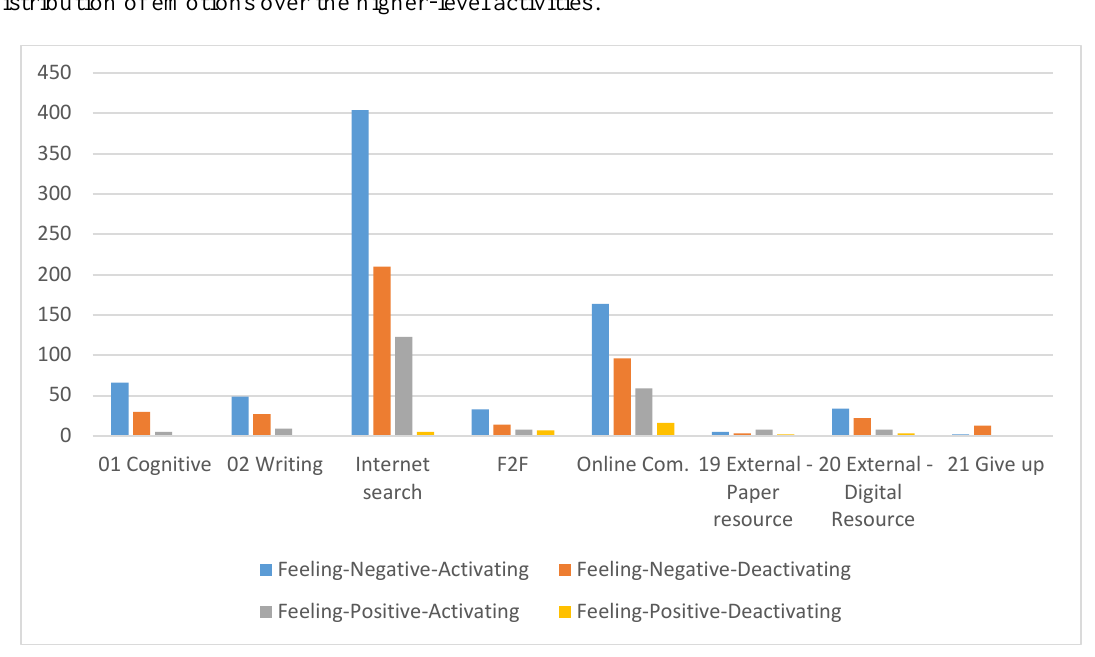
Figure 4. Emotion distribution over higher-level